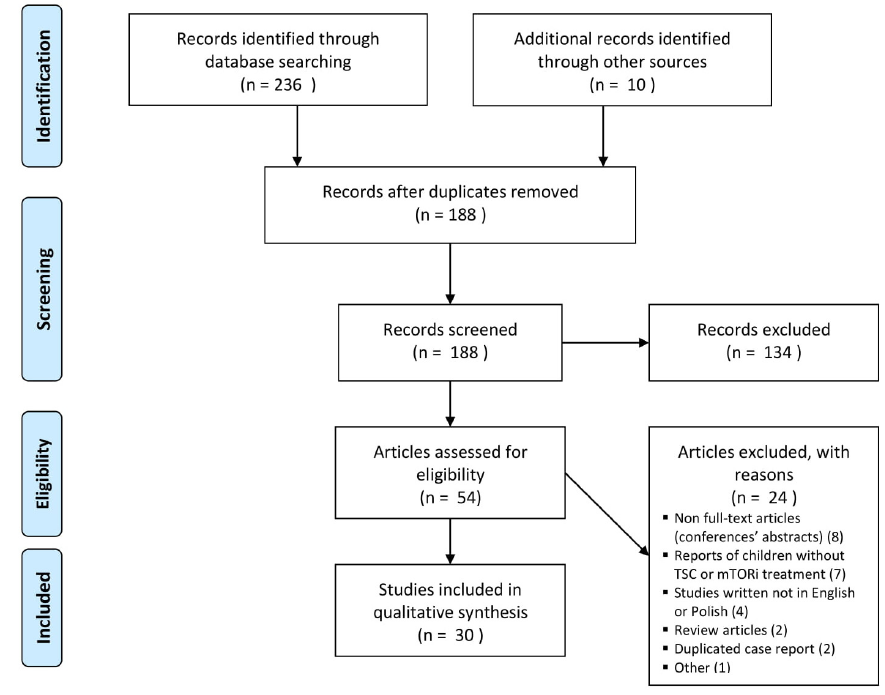
Figure 1. Flow diagram of the study